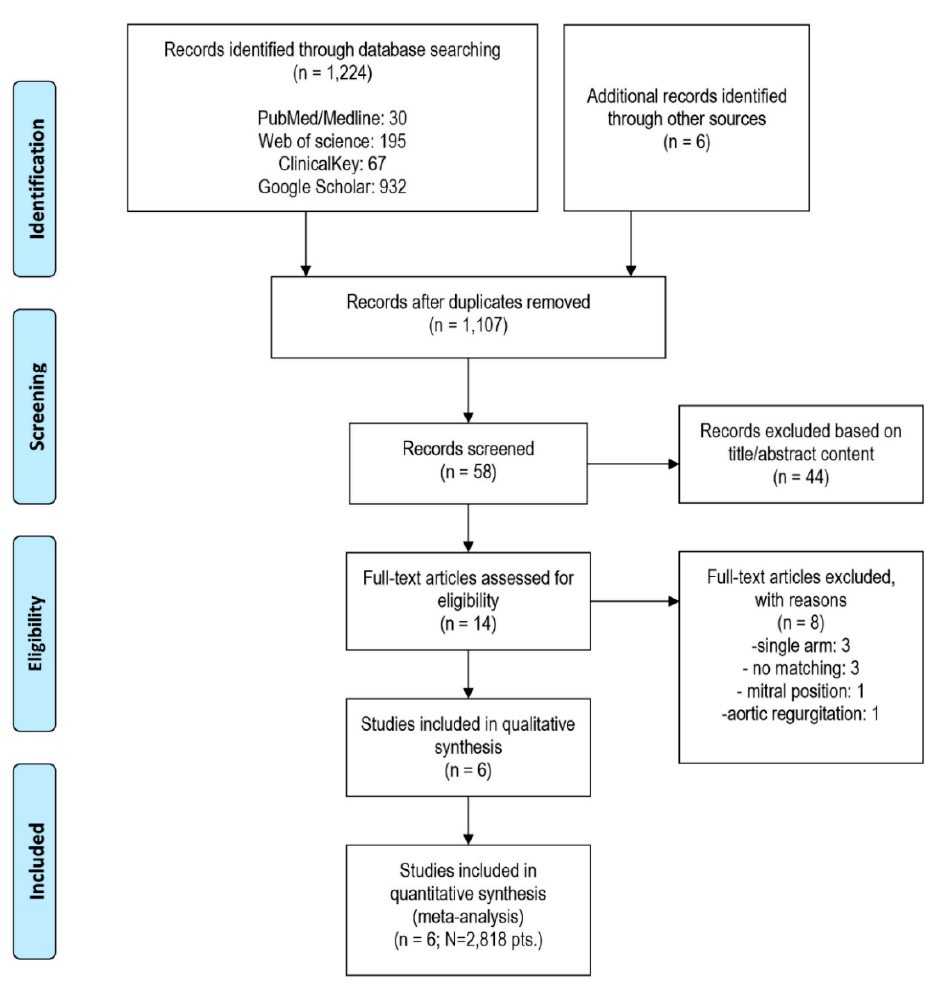
Figure 1. Study selection and inclusion process.